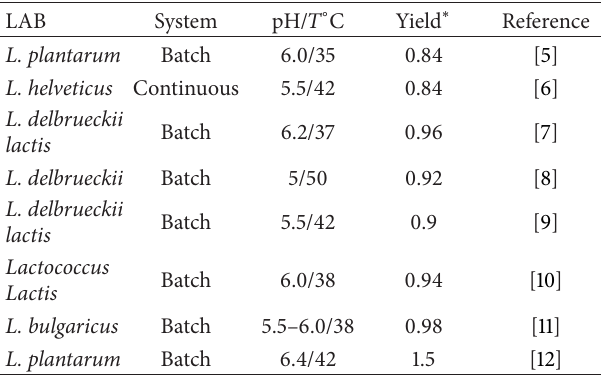
Table 1: Yields obtained in different fermentation conditions using lactic acid